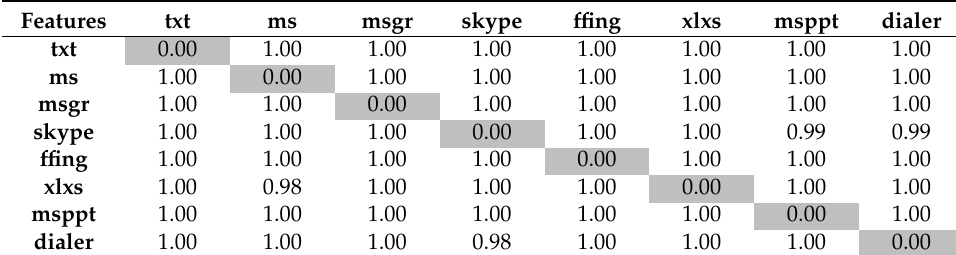
Table 4. Matrix of similarity for non-similar